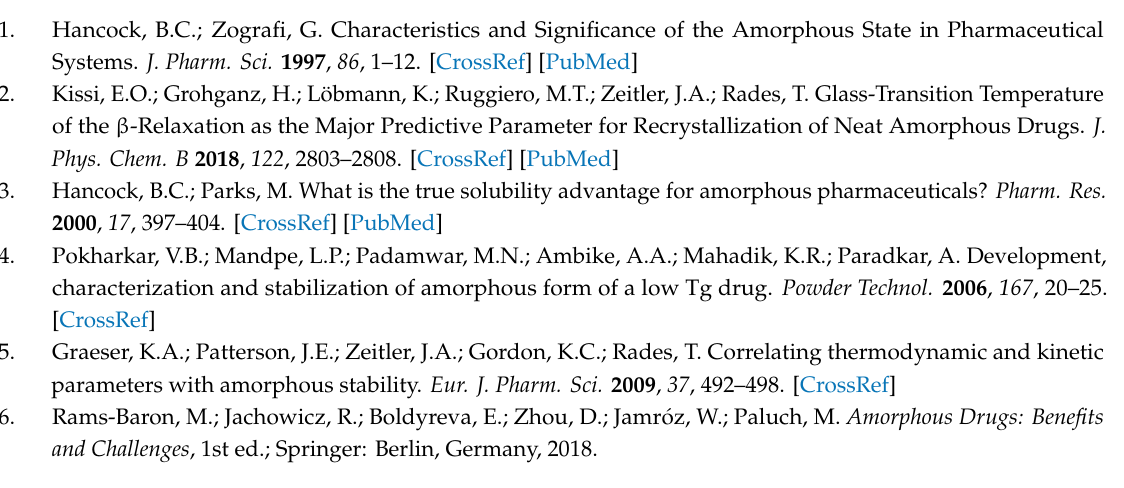
Figure S1: Heat-flow vs. temperature plots from the physical ageing of indapamide at ( a ) 35, ( b ) 40 and ( c ) 45 ◦ C. Figure S2: Experimental enthalpy of crystalline h DSC (exp-cr) and amorphous unaged h DSC (exp-am on cooling) and aged h DSC (exp-aged) indapamide as measured by DSC in the frame of the calculated enthalpy in the solid and h (crystal) = h (solid) and liquid and h (liquid) states. Additionally, the enthalpy of aged amorphous indapamide, h DSC (exp-aged), is presented ( T a = 85 ◦ C for 32 h at 0% relative humidity (RH)). Table S1: Fictive temperature (Tf) vs. aging time (ta) of indapamide aged at Ta = 65, 75 and 85 ◦